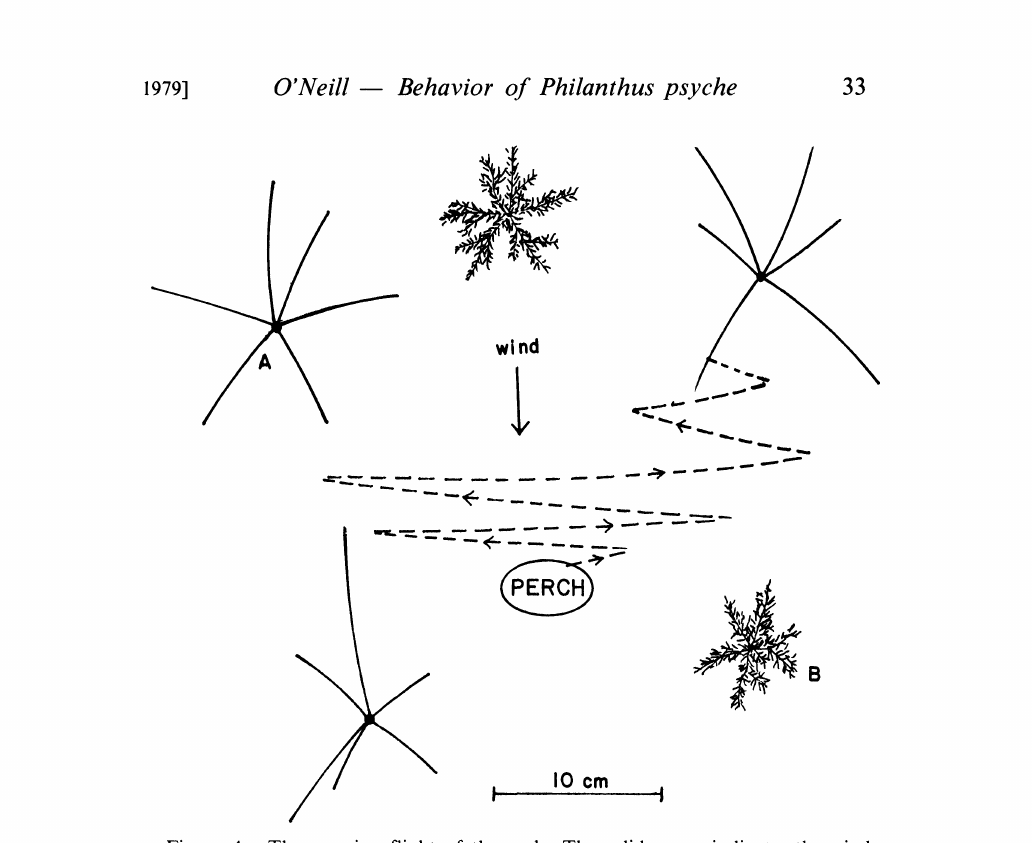
Figure 4. The weaving flight of the male. The solid arrow indicates the wind direction. The dashed line indicates the flight path of the male. to the perch, respectively. Even when plants downwind of the perch were marked, the male often flew downwind of the plants before dragging his